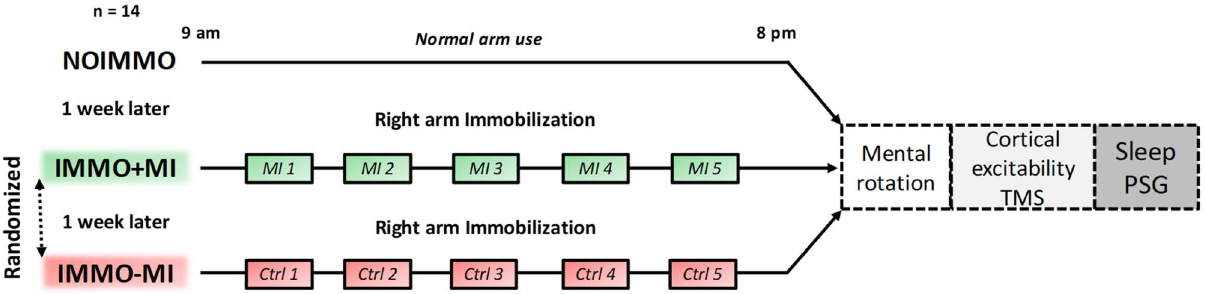
Figure 1. Experimental design. Participants underwent three experimental conditions, separated by one week each, including one normal 11-h awake period without immobilization (NOIMMO), 11 h of arm immobilization with MI treatment (IMMO+MI condition; including 5 MI sessions), and a similar immobilization period without MI (IMMO−MI condition; including 5 control task sessions). Order of IMMO+MI and IMMO-MI was randomized. After each experimental condition, we assessed changes in sensorimotor representations (hand laterality judgment task) and cortical excitability (TMS) over both M1s. PSG data were recorded during the night following each daytime